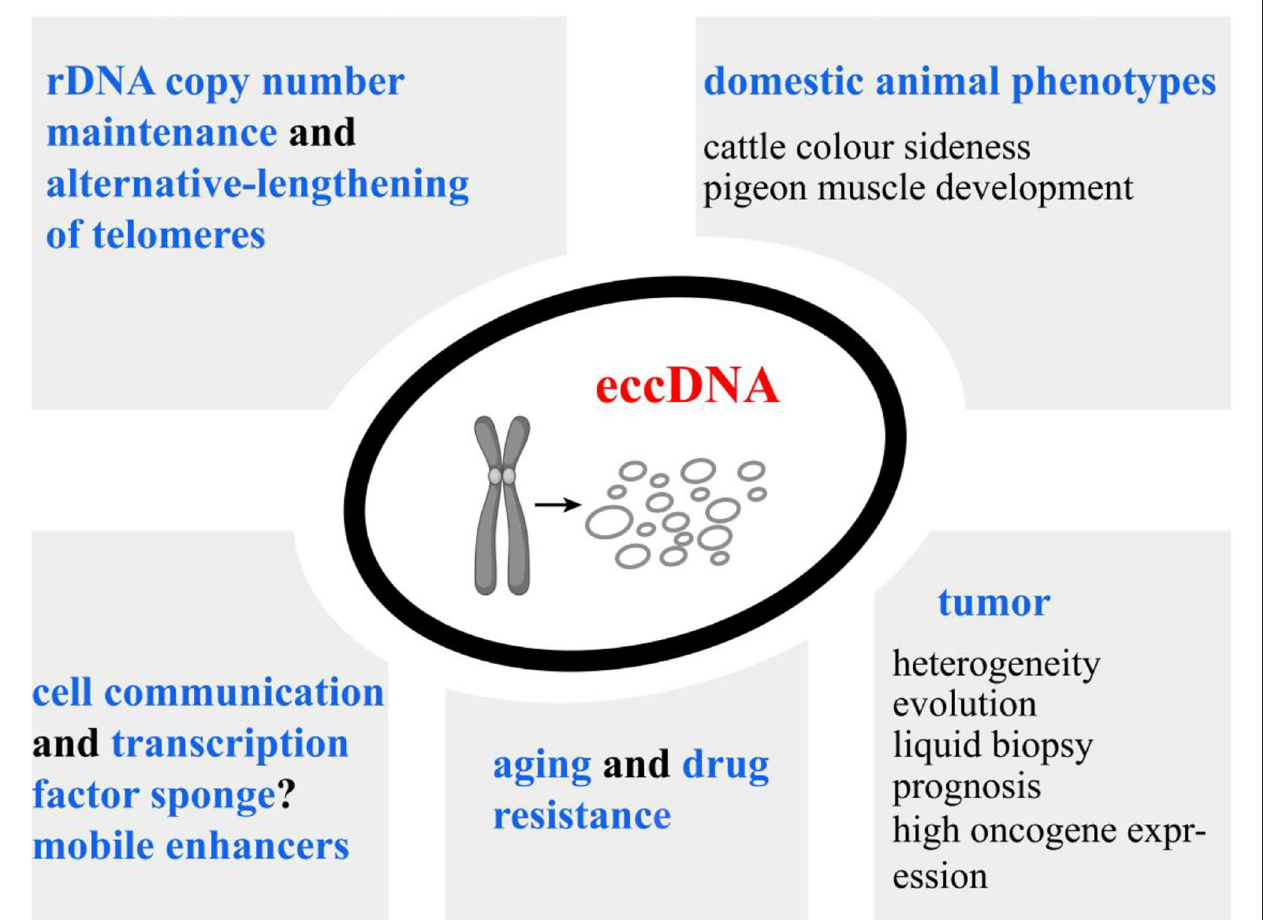
FIGURE 4 | Overview of our current understanding of extrachromosomal circular DNA (eccDNA) functions. High copy number and significant transcriptional activity of eccDNAs lead to the overexpression of the inhabiting genes. Additionally, eccDNAs could serve as mobile enhancers to trans-regulate chromosomal genes. eccDNAs have been associated with cancer prognosis, drug resistance of plants, and phenotypic variations of animals, implying their potential implications in life science. MicroDNA can be released from normal tissues. Establishing the associations of microDNA copy numbers with economic traits is an important direction for future